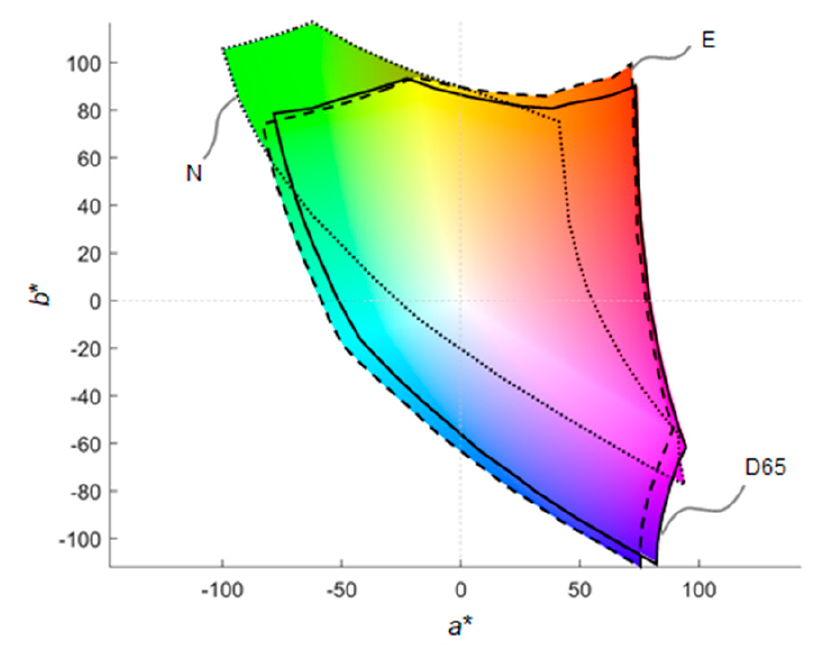
Figure 6. CIELAB projection of the full 3-D gamuts onto the a * b * plane for different white points (N, E, D65) of the dipic series.